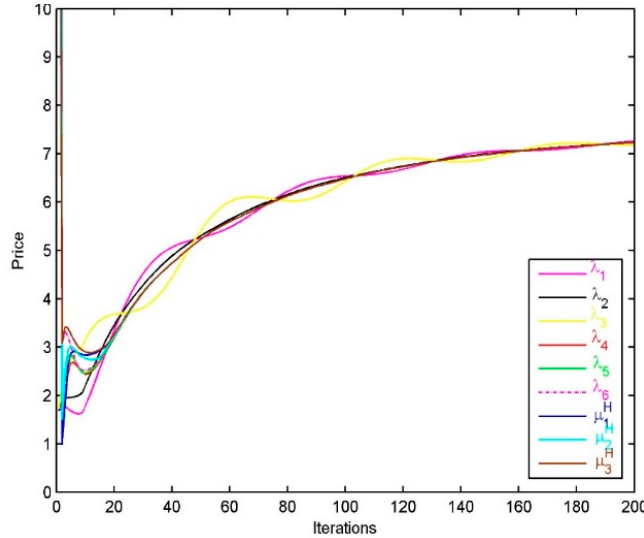
Figure 8. Performance of the resource allocation algorithm for customer 𝑟 : Prices.